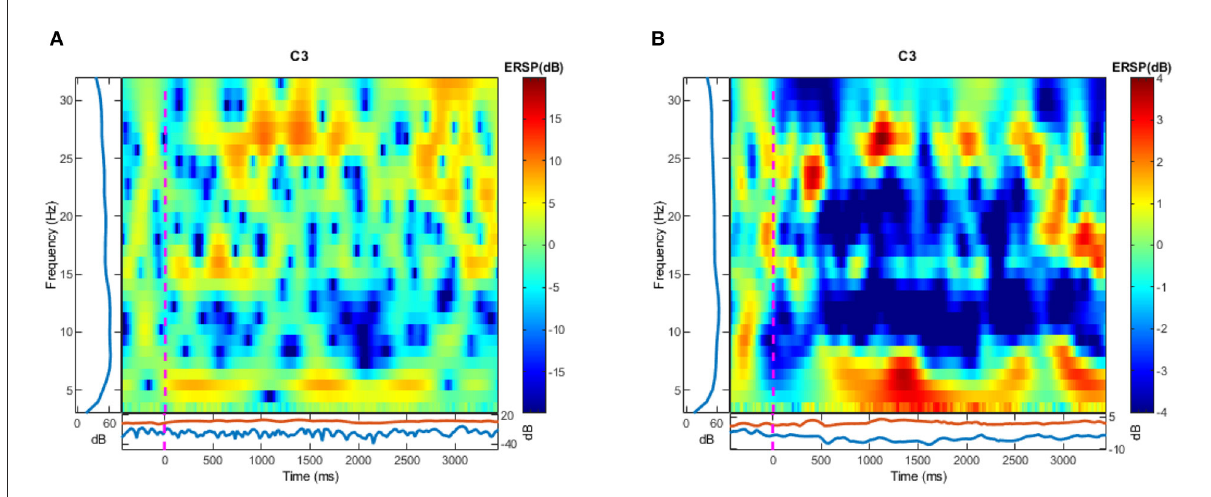
FIGURE3 The visualization of ERSP calculation in C3 channel. (A) Is the result calculated by one trial and (B) is calculated by 10 trials picked randomly from all trials. Blue areas show the ERD while the red areas show the ERS.